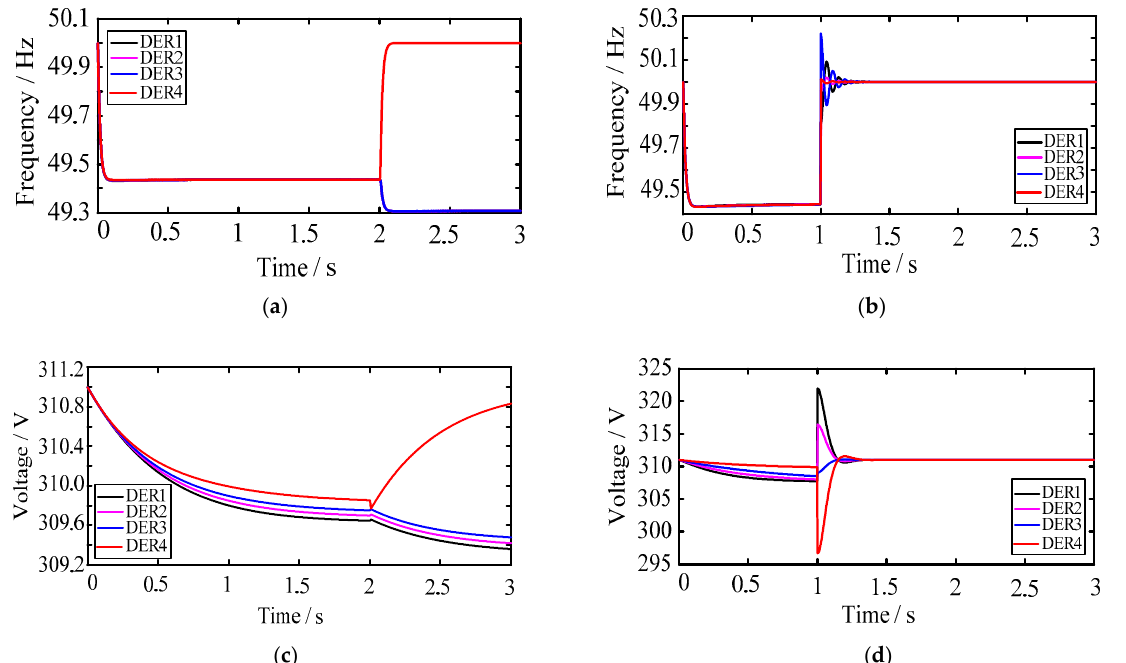
Figure 8. Variations of DERs when DER4 is added at t = 2 s. ( a ) Variations of voltage by using traditional droop control; ( b ) Variations of voltage by using the novel distributed control; ( c ) Variations of frequency by using traditional droop control; ( d ) Variations of frequency by using the novel distributed control.